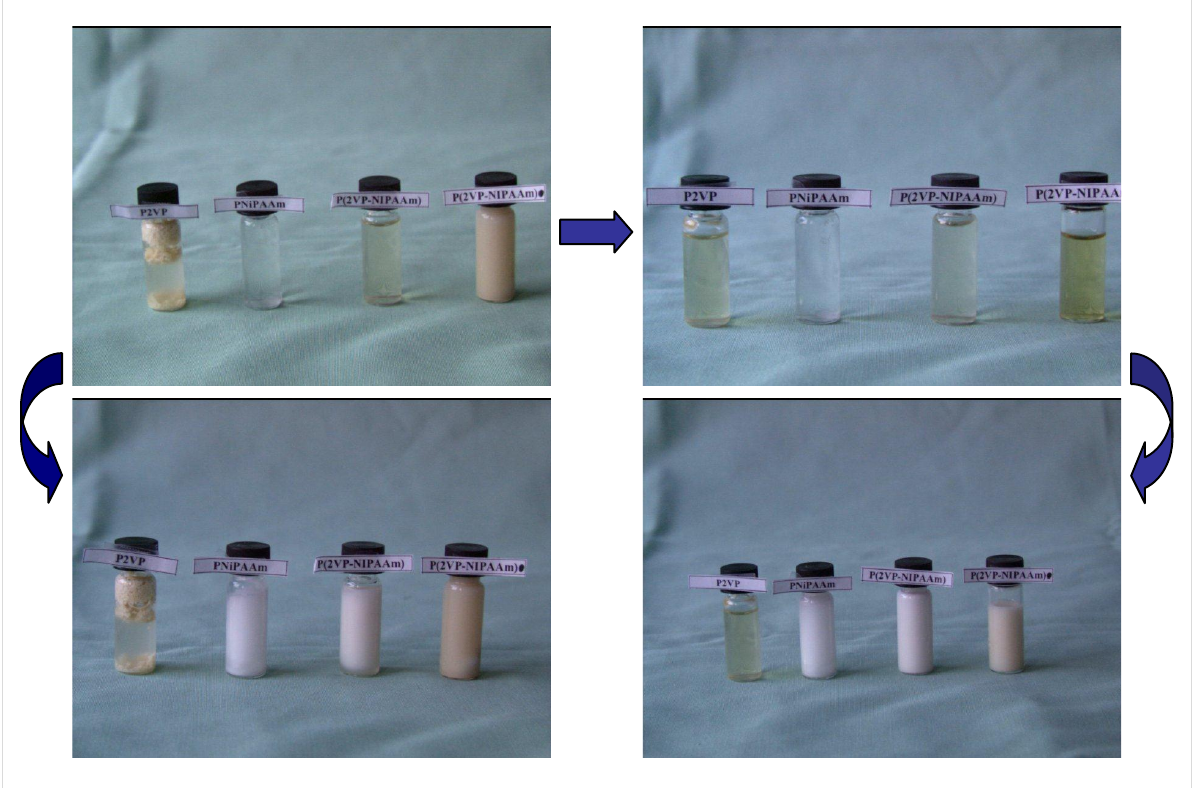
Figure 7: Demonstration of the solution behavior. Polymers from left to right: P2VP, PNIPAAm, P(2VP) 85 - block -P(NIPAAm) 351 , P(2VP) 114 - block - P(NIPAAm) 244 ; a) pH7 and RT, b) pH 4 and RT, c) pH 7 and T > 35 °C, d) pH 4 and T > 35 °C.